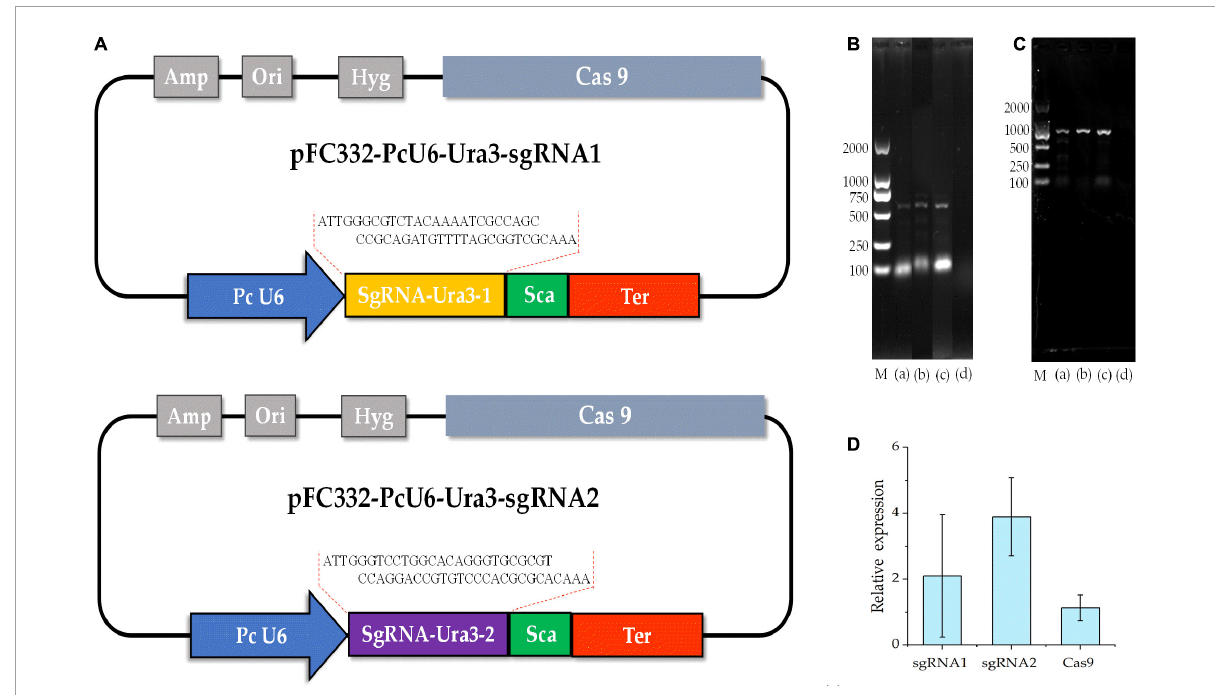
FIGURE4 The diagram of CRISPR-Cas9 system with different sgRNA target sites and detection of sgRNA and Cas9 of the transformants. (A) The schematic of the vector pFC332-PcU6-Ura3-sgRNA1 and pFC332-PcU6-Ura3-sgRNA2; (B) agarose gel electrophoresis of PCR products of sgRNA; (C) agarose gel electrophoresis of PCR products of Cas9; M, DNA ladder 2000 Marker; (a) plasmid; (b) ura3-sgRNA1 transformants; (c) ura3-sgRNA2 transformants; (d) wild type; and (D) the relative expression of the genes of sgRNA1, sgRNA2, and Cas9.